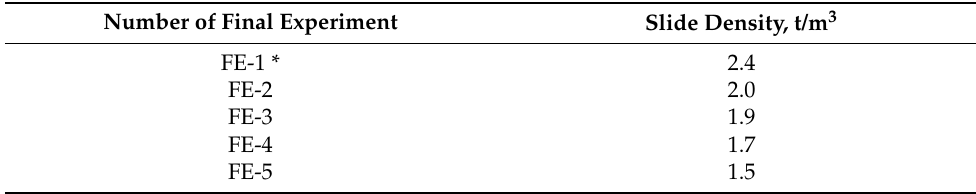
Table 4. Summary of characteristic quantities of the final experiments